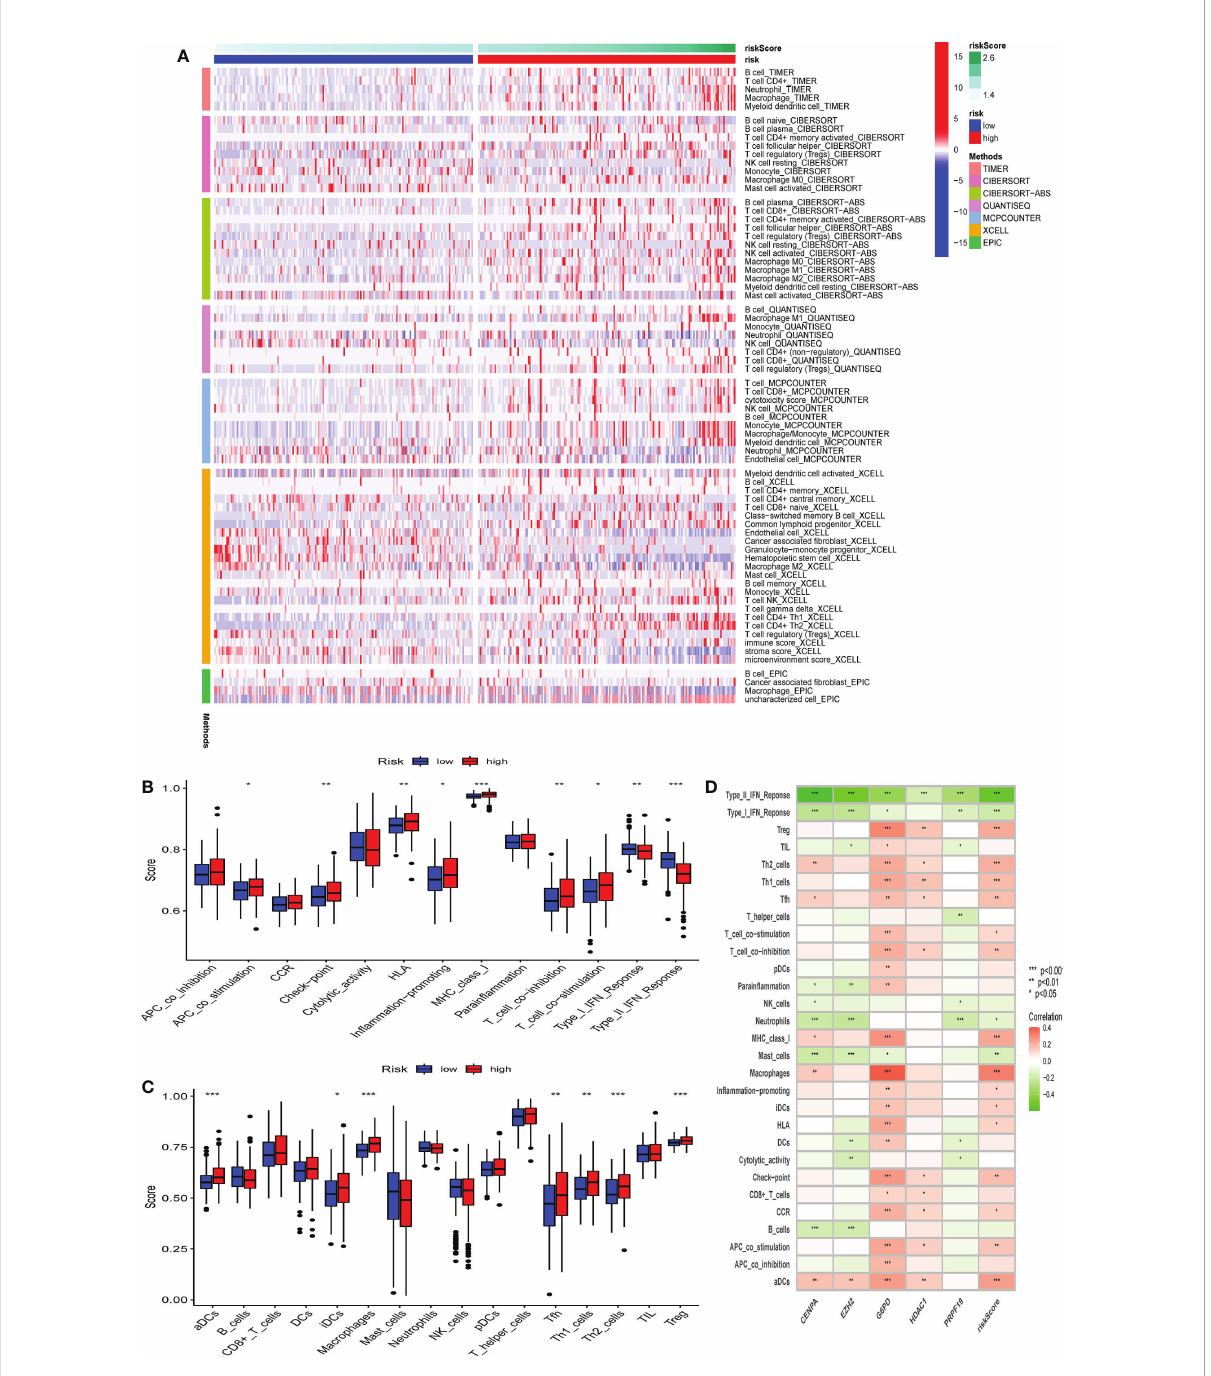
FIGURE 8 The difference in immune in fi ltration among patients in different risk groups. (A) Seven deconvolution immunization algorithms visualise the immune cell differences between high and low-risk groups. (B-C) The box plot illustrated the absolute abundance scores of the 16 immune cells and 13 immune function components in different risk groups. (D) The correlation heatmap between the absolute abundance scores of immune cells and the immune function and the CS-score. *Adjusted p < 0.05, ** adjusted p < 0.01, *** adjusted p <